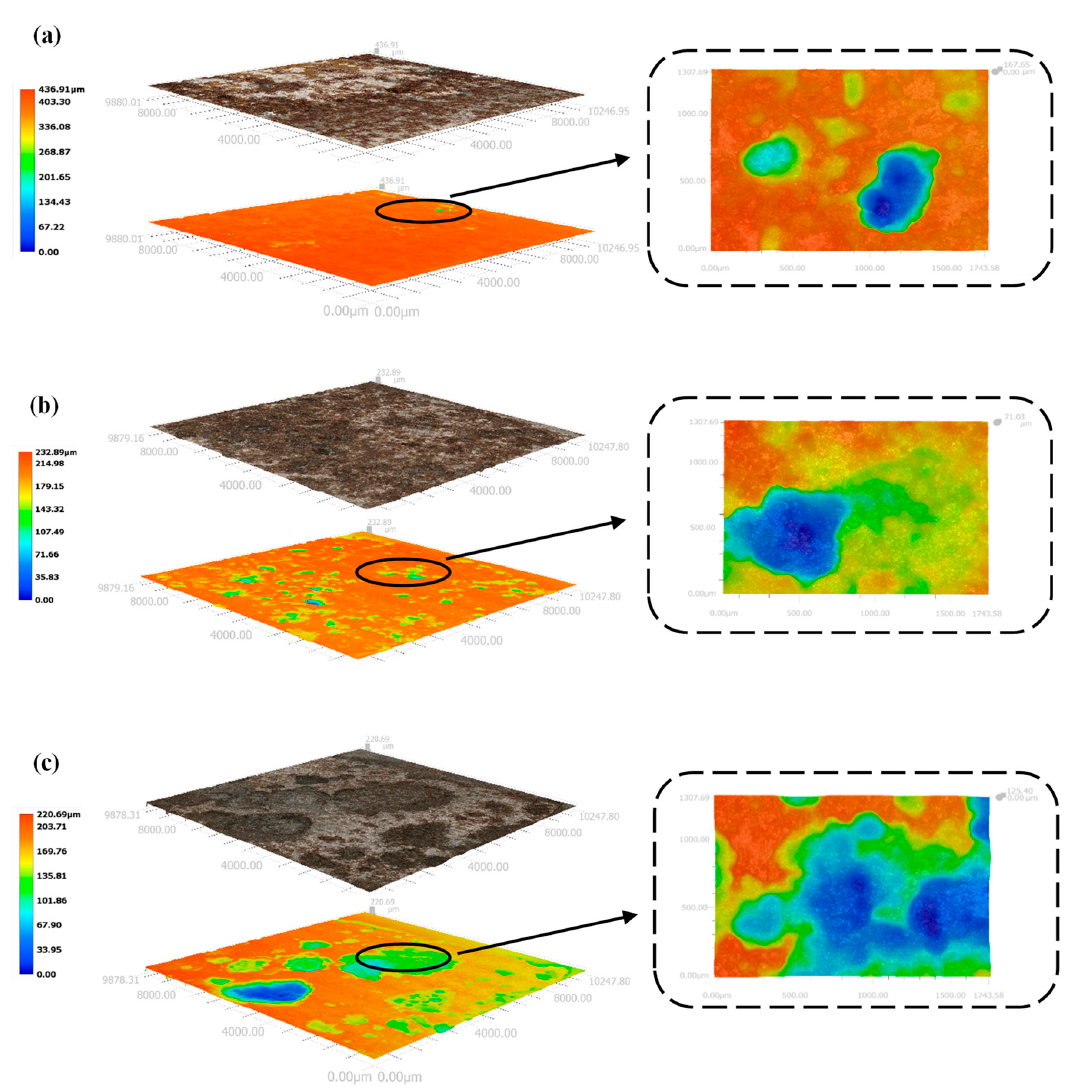
Figure 15. Three-dimensional morphological images of corrosion pits on the surface of X70 steel at the height of 12 # of soil column: ( a ) 0%, ( b ) 0.3%, ( c ) 1.0% NaCl.